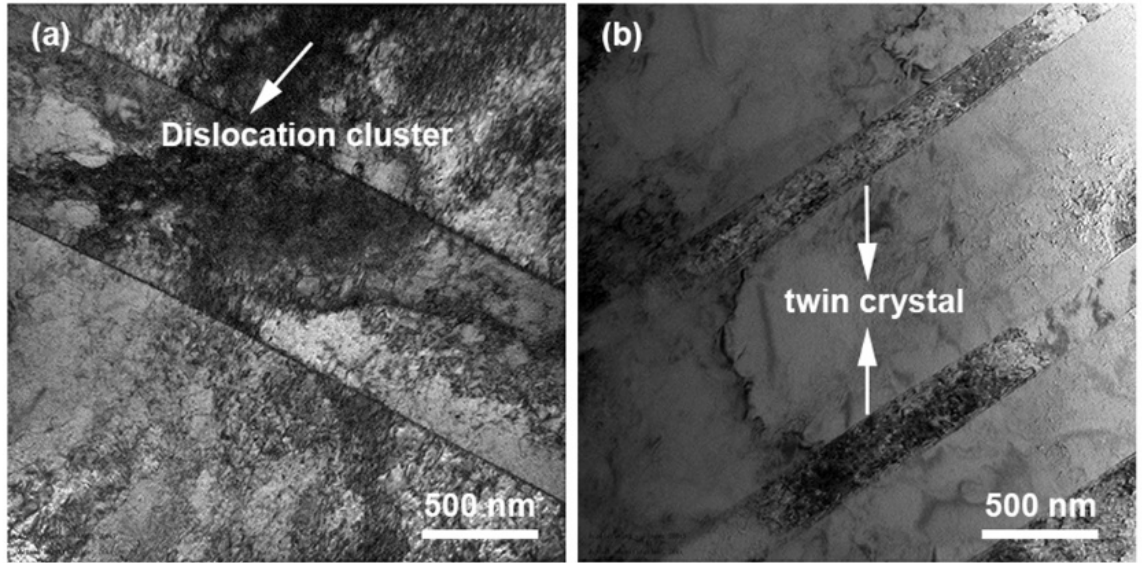
Figure 5. TEM bright field images of specimens after being intermediate annealed with different contents of P; ( a ) pure Cu, ( b ) P23.